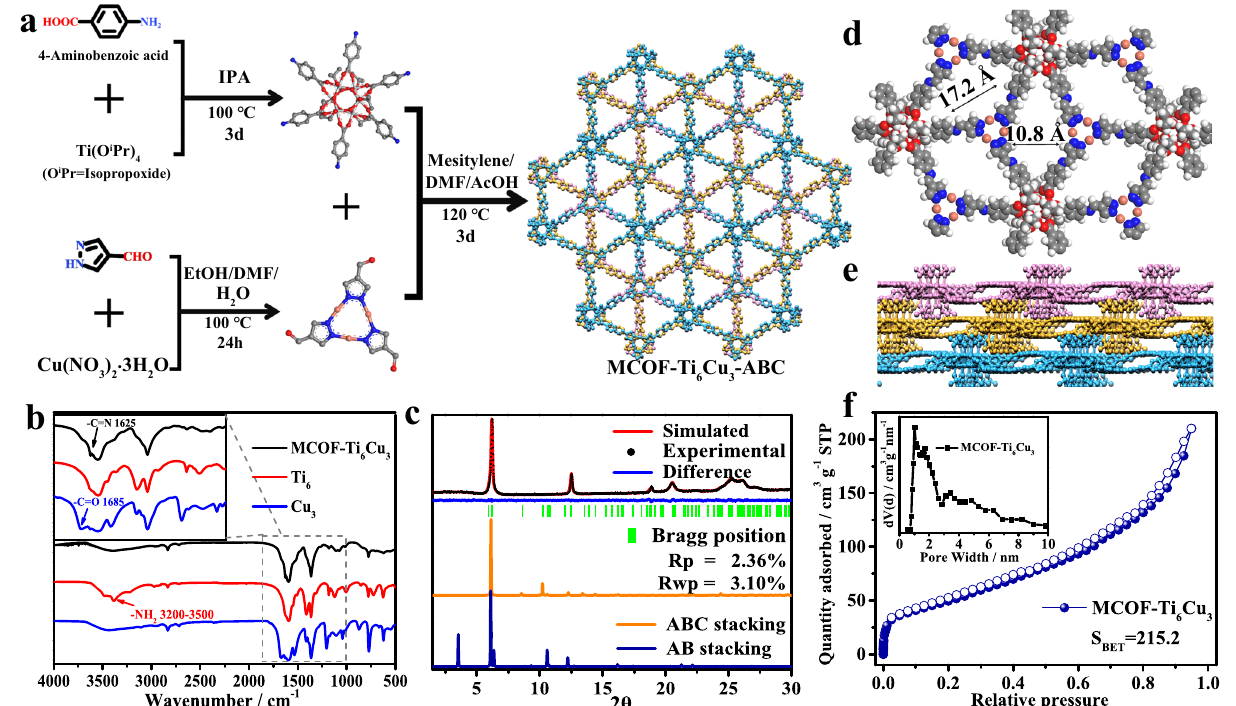
Fig. 1 | The preparation and characterization. a Schematic of the synthesis of